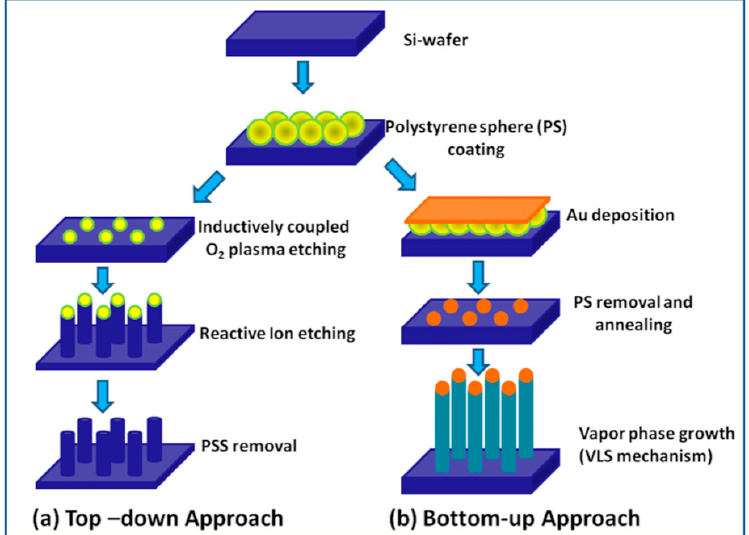
Figure 2. Schematic presentation of general steps involved in the fabrication of nanowires (NWs) using ( a ) top-down and ( b ) bottom-up approaches. Reproduced with permission from Ramgir et al. [130]. Copyright 2013: Elsevier.